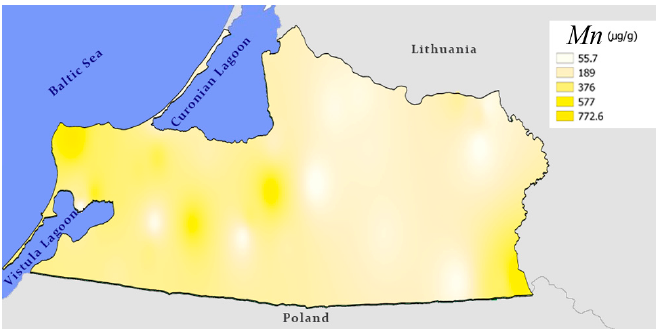
Figure 4. Distribution of manganese in the thalli of H. physodes in the Kaliningrad region, 2010. The concentration of zinc in lichens changed over a wide range—from 33 to 298 μ g/g, with the coefficient of variation at 56%. The highest zinc concentrations were found in the northern part of the region in the River Neman valley (Figure 5).